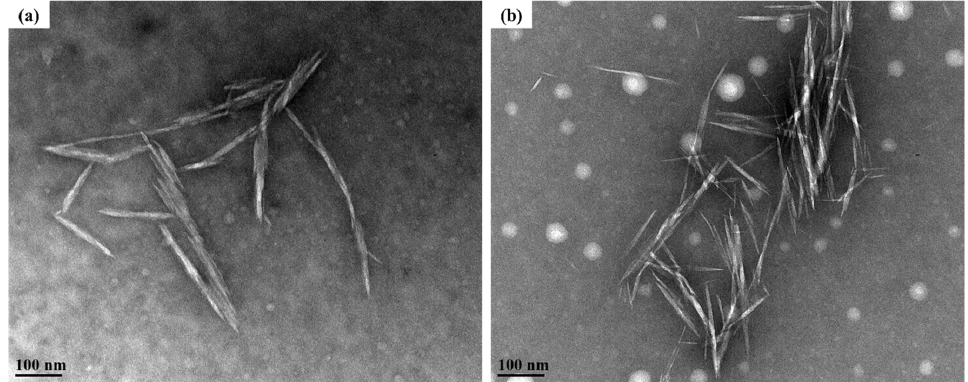
Figure 2. Transmission electron microscopy (TEM) images (×110,000 magnification) of HCNCs ( a ) and TCNCs ( b ).